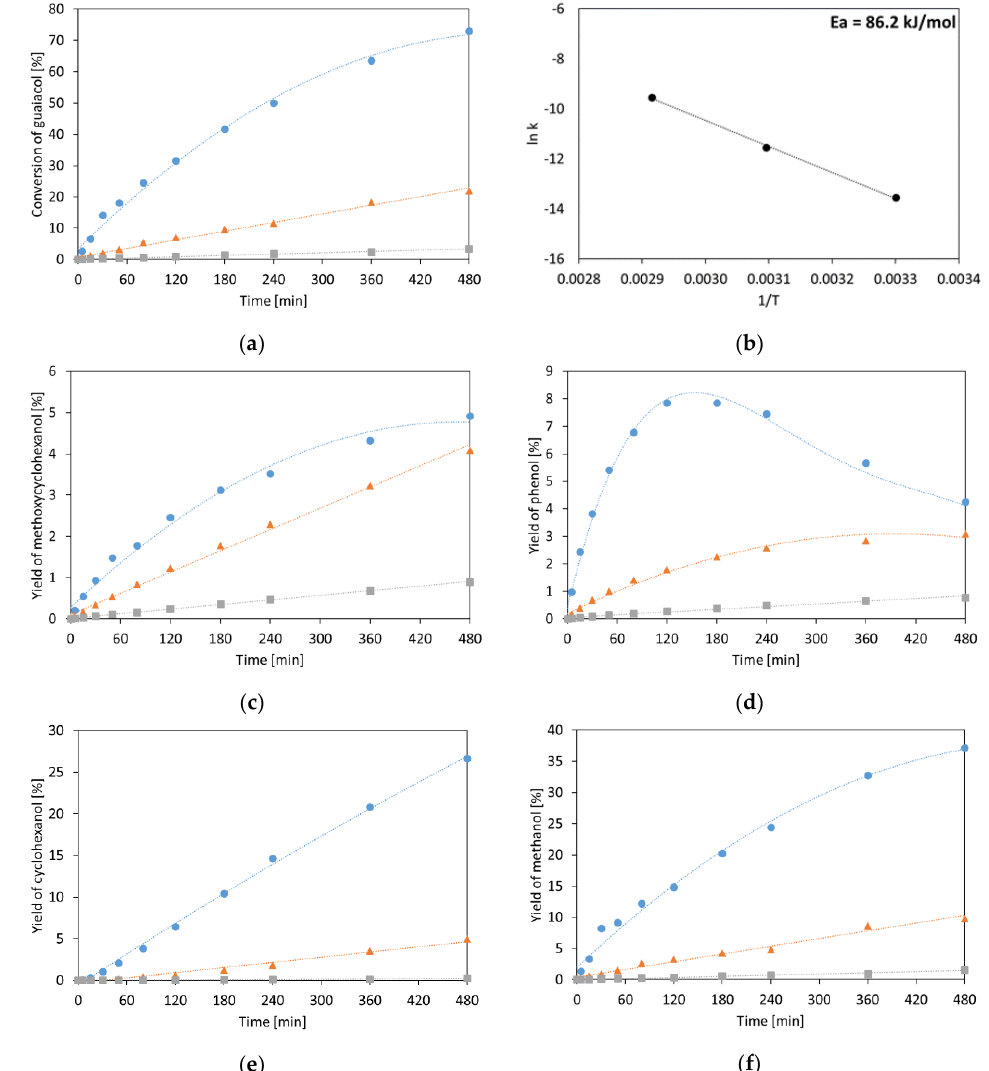
Figure 1. ( a ) Conversion of guaiacol, ( b ) Arrhenius plot. Yield of ( c ) methoxycyclohexanol, ( d ) phenol, ( e ) cyclohexanol, and ( f ) methanol at 30, 50, and 70 °C. ( e ) cyclohexanol, and ( f ) methanol at 30, 50, and 70 ◦